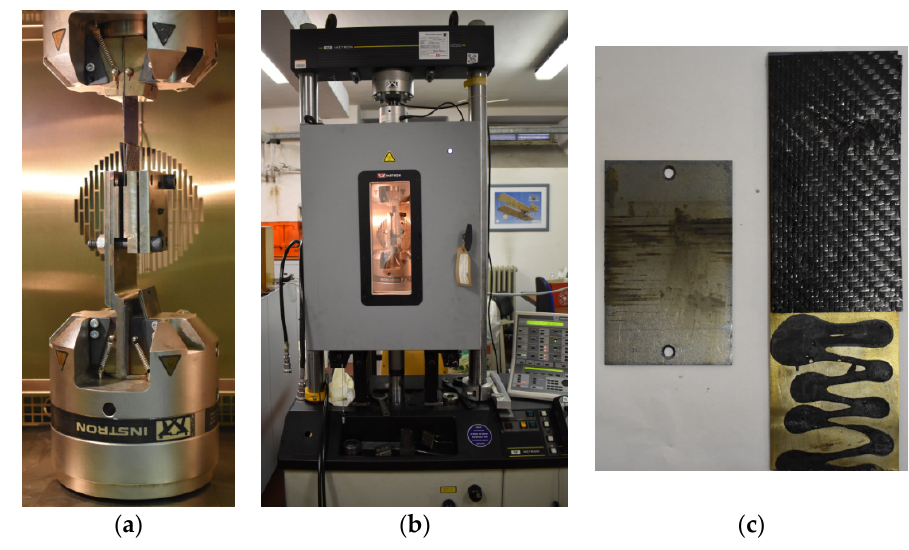
Figure 6. Tool-ply test: experimental setup ( a ), climatic chamber ( b ), specimen ( c ).